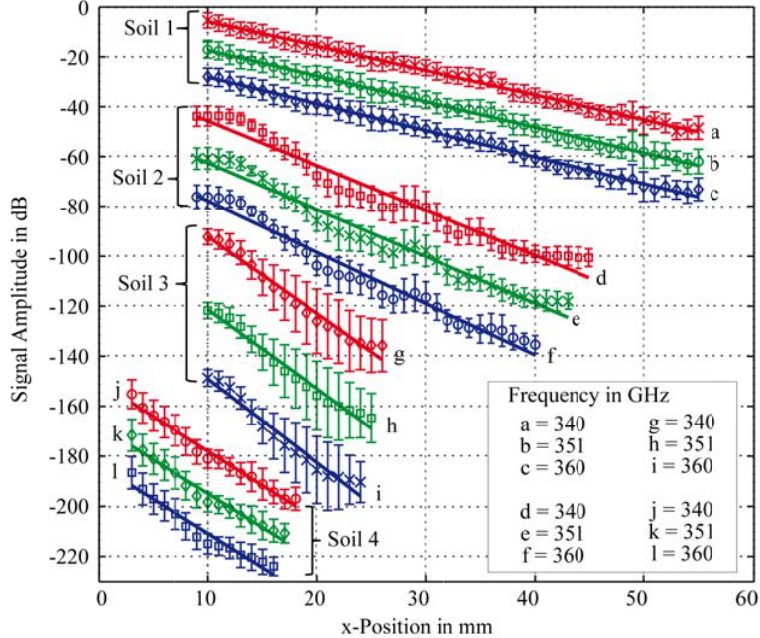
e 8. Plots o holder r for the fou soil thi ickness by